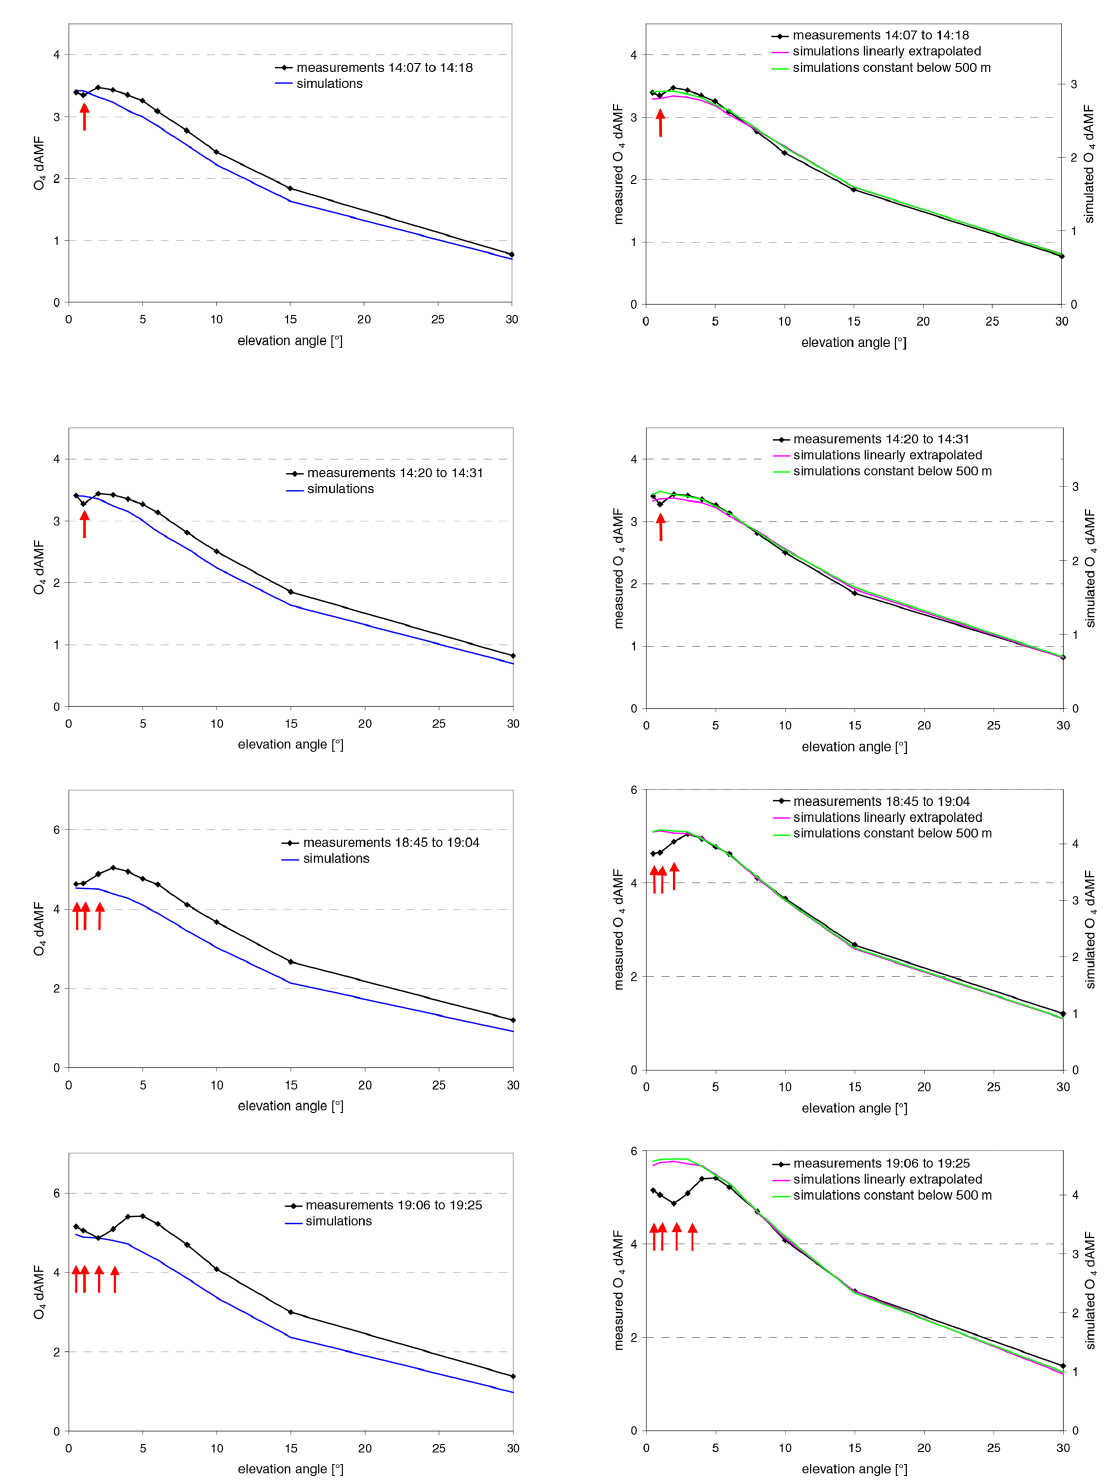
Figure A12. Comparison of the measured and simulated O 4 dAMFs for five elevation sequences with few cloud-contaminated measurements (indicated by the red arrows). On the left side, the measured O 4 dAMFs are compared to simulations for a pure Rayleigh atmosphere. On the right side, they are compared to simulation results including aerosols (two profiles with either constant or linearly extrapolated aerosol extinction below 500m). Note that on the right side, separate y axes on the right sides are used for the simulation results. The maxima of the right y axes are chosen to achieve the best agreement between the measured and simulated O 4 dAMFs (see text). Note that for the last elevation sequence (19:06–19:25UTC), the AOD used in the forward model has large uncertainties; see Sect. 2.2.